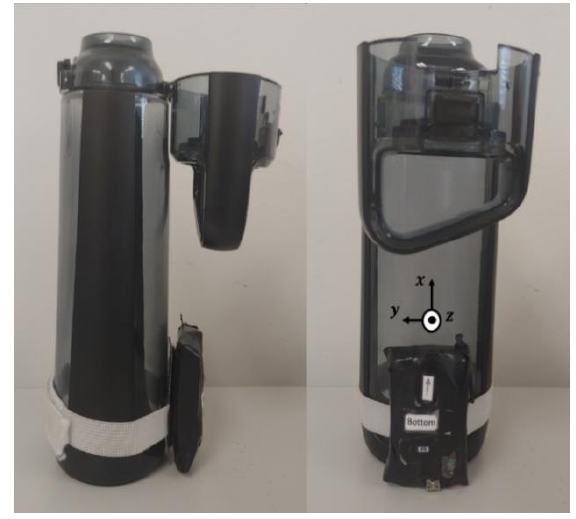
Figure 1. Refillable bottle with attached sensor prototype.